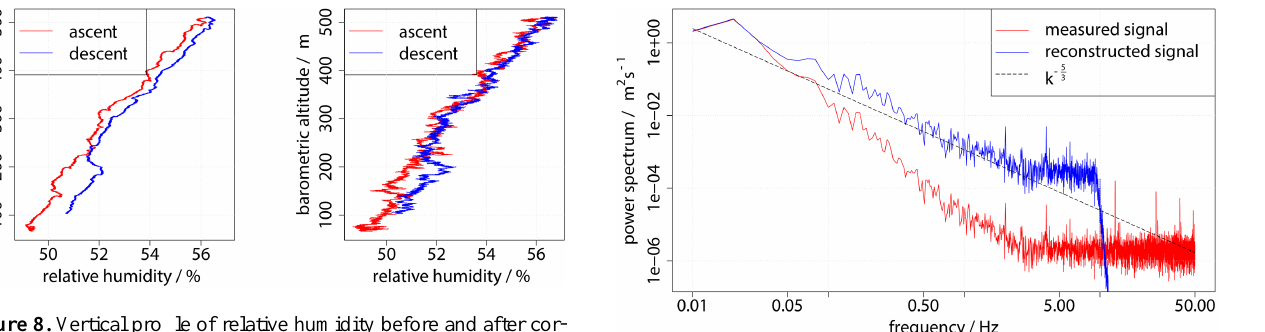
Figure 8. Vertical profile of relative humidity before and after cor- rection.